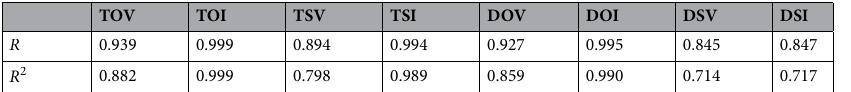
Table 8. Correlation coefficients between the predicted and the observed fixation proportion on AOIs for each experimental condition.